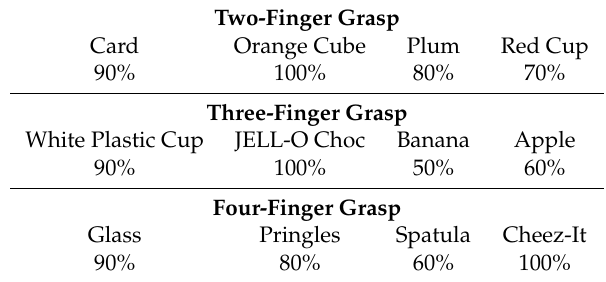
Table 1. Assessment of the stabilization success rates for several objects. Ten stabilization trials are performed for each object and the rate of successful stabilization is